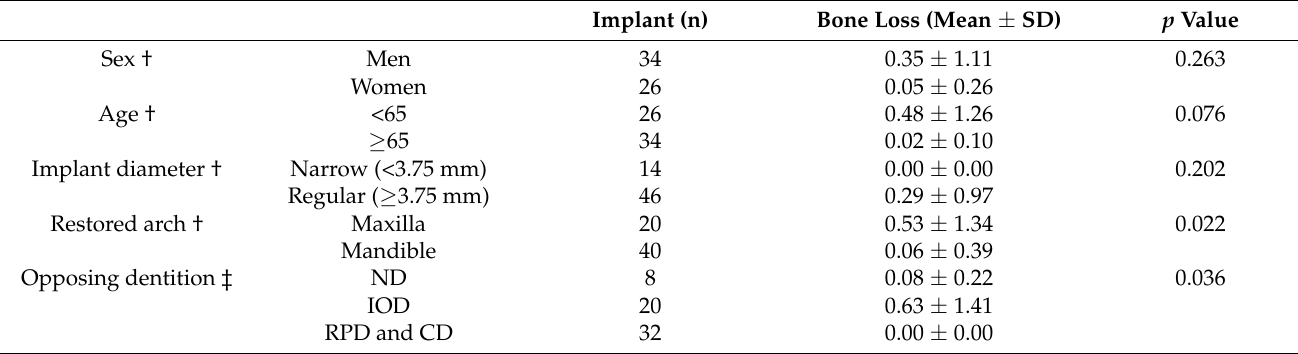
Table 7. Marginal bone loss of implants (mm).